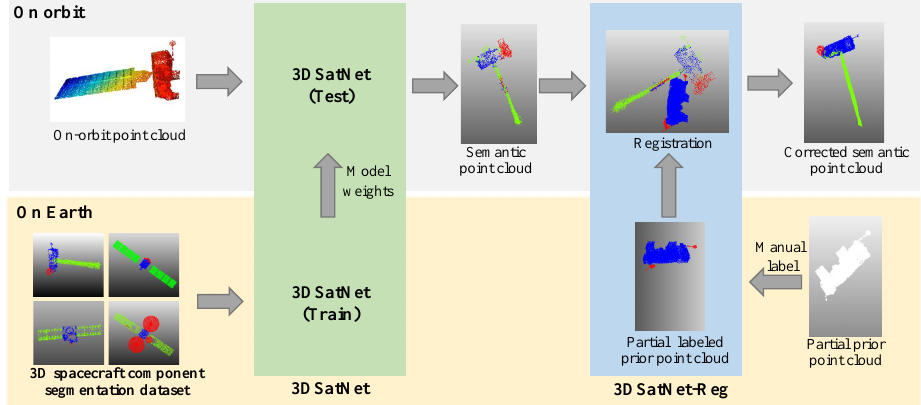
Figure 1. The pipeline of the proposed 3D spacecraft component segmentation